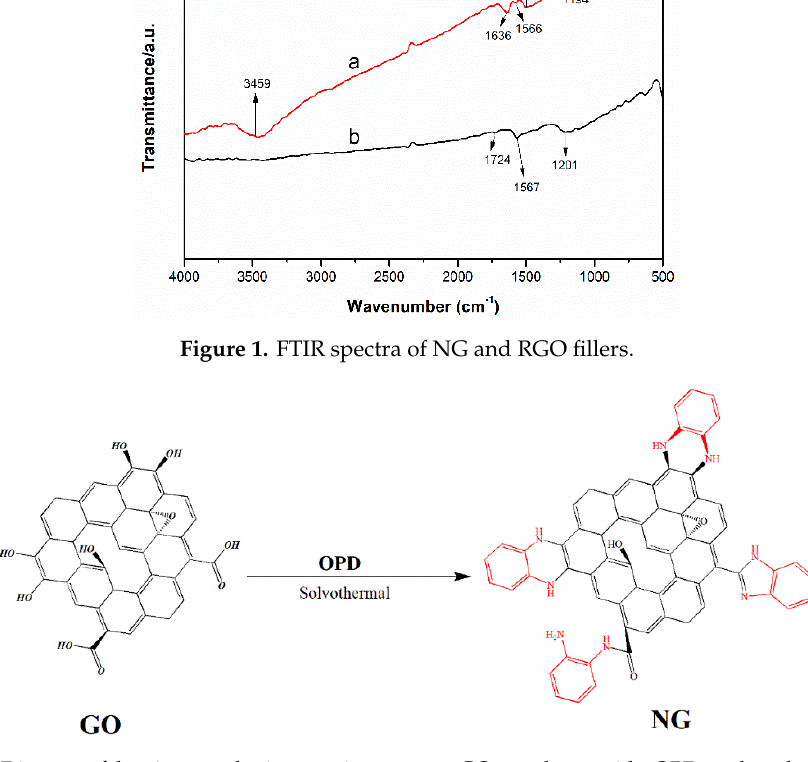
Figure 2. Diagramofthenitrogen-dopingreactionprocess. Figure 2. Diagram of the nitrogen-doping reaction process. GO: graphene oxide, OPD: o- phenylenediamine.